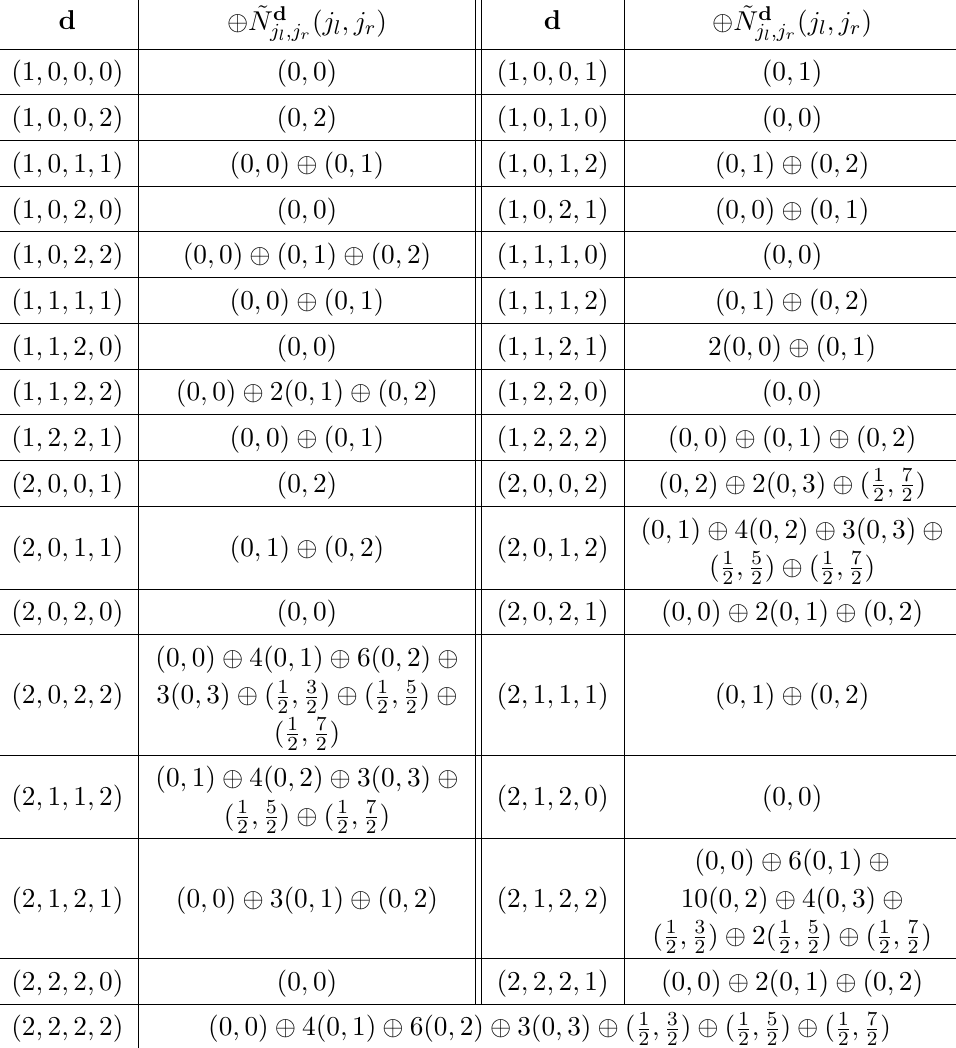
Table 12 . Spectrum of the fundamental Wilson loop states in the SU(4) 6 theory for d i ≤ 2 . Here, d = ( d 1 , d 2 , d 3 , d 4 ) labels the BPS states with fugacity Q − 1 / 4